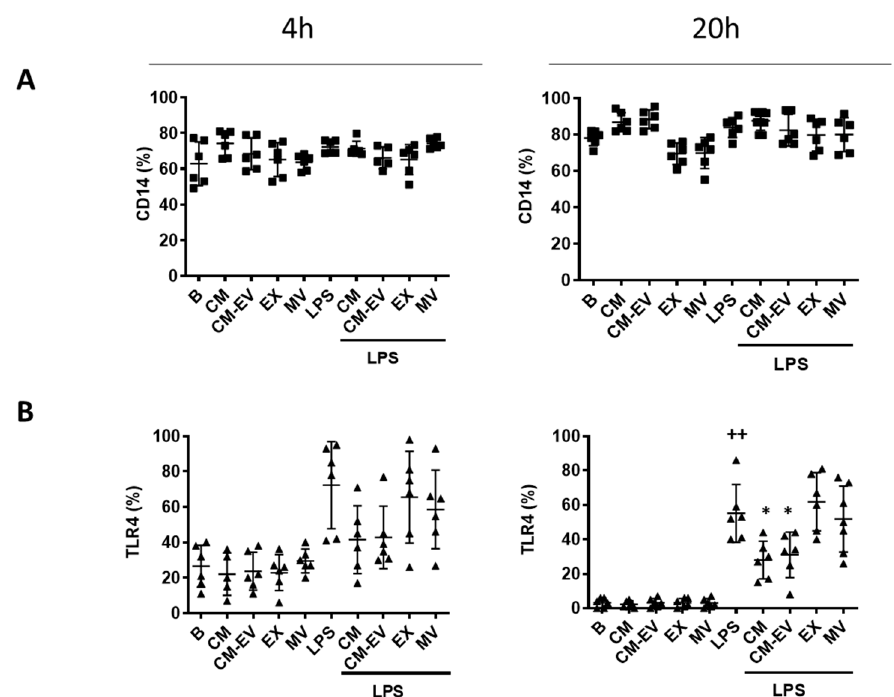
Figure 4. Expression of CD14 ( A ) and TLR4 ( B ). Macrophages were incubated with CM, CM-EV, EX, or MV in the presence or absence of LPS for 4 h or 20 h. Protein expression of CD14 and TLR4 was determined by flow cytometry. B: cells incubated with control medium and not stimulated with LPS. Data are presented as mean ± SD ( n = 6) from 3 independent experiments. One-way analysis of variance followed by Tukey’s post hoc test; ++ p < 0.001 versus B; * p < 0.05 versus LPS